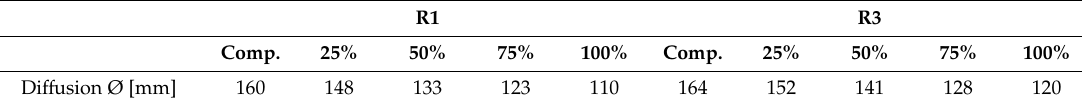
Table 3. Consistency of fresh mixture.